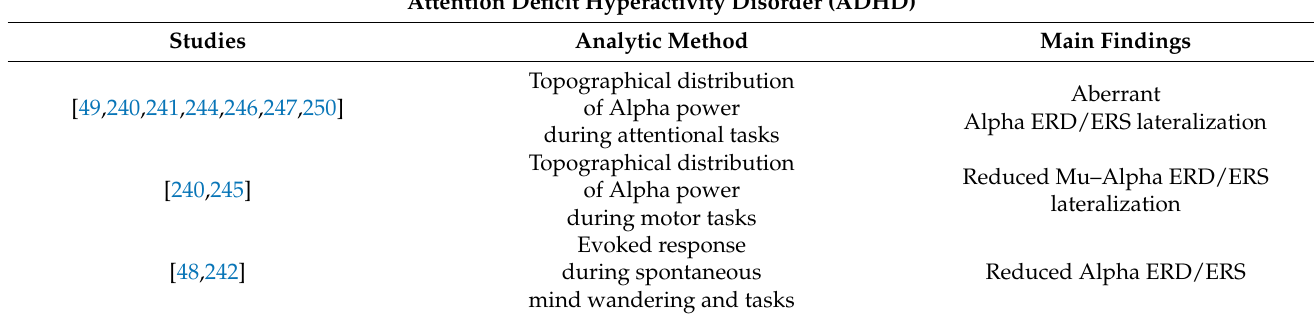
Table 5. Table representing the main electrophysiological findings in ADHD, with the methods and the studies who contributed to